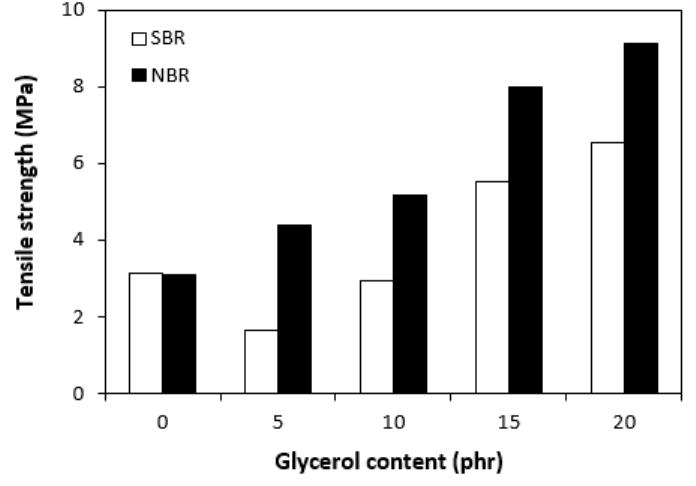
Figure 14. Influence of glycerol content on tensile strength of vulcanizates.